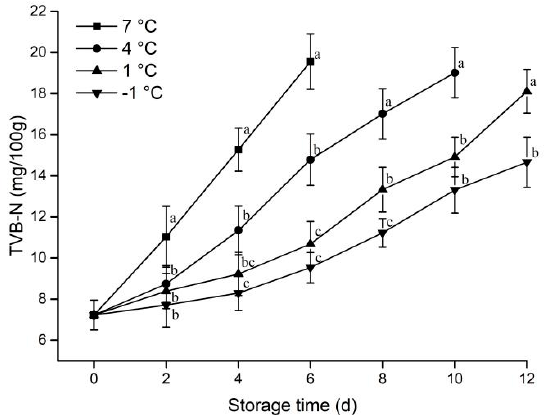
Figure 5. Effect of different storage temperatures on TBARS of pork. Different lowercase letters (a − c) indicate significant difference (p < 0.05 ) between each treatment on the same storage time.